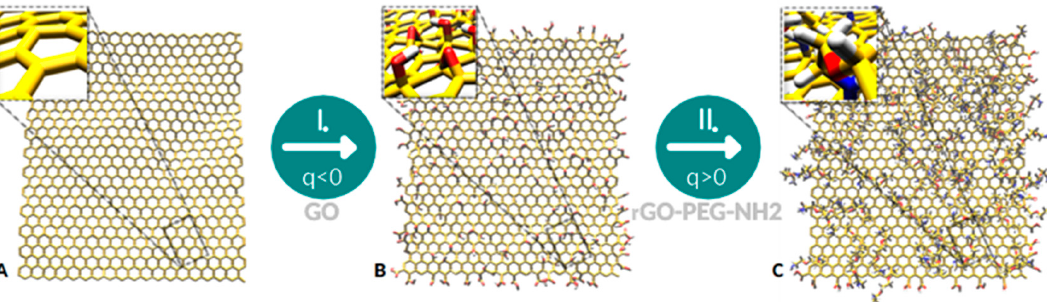
Figure 2. Models of the three different graphenic species involved in obtaining the topologies used in the simulations: ( A ) Pristine graphene; ( B ) graphene Oxide (GO) obtained from pristine graphene, with a negative net charge; ( C ) aminated graphene NH 2 -PEG (rGO-PEG-NH 2 ) obtained from GO, with a positive net charge.